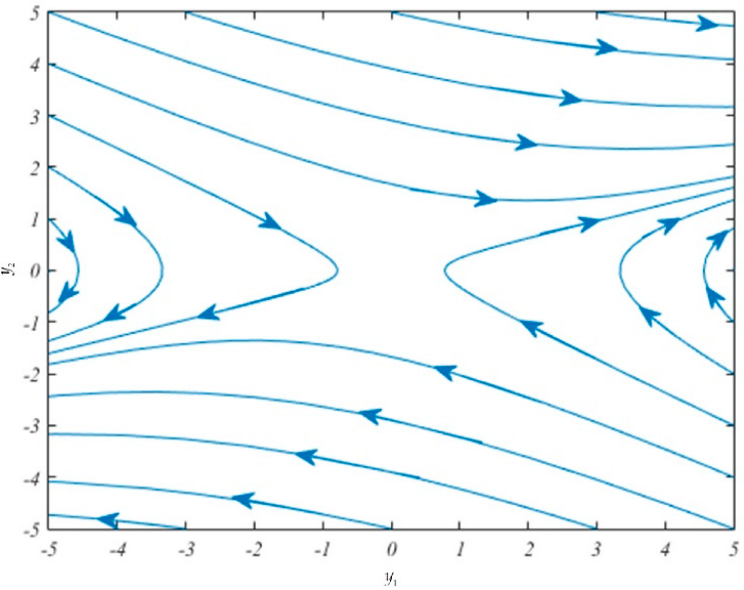
( y ) -plane, of the model system (13). ( , ) y y − plane, of the model system (13). Figure 1. Plot of the phase portrait, in the 1 , y 2 1 2